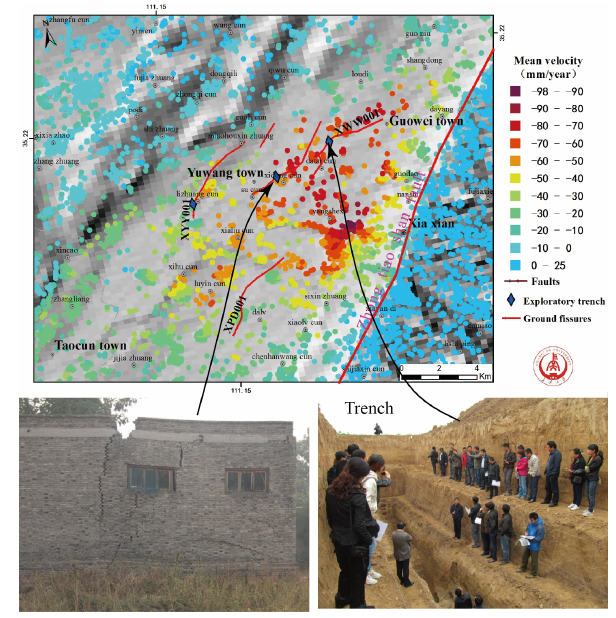
Figure 5. Ground fissure deformation map in Xia County, Yuncheng basin.